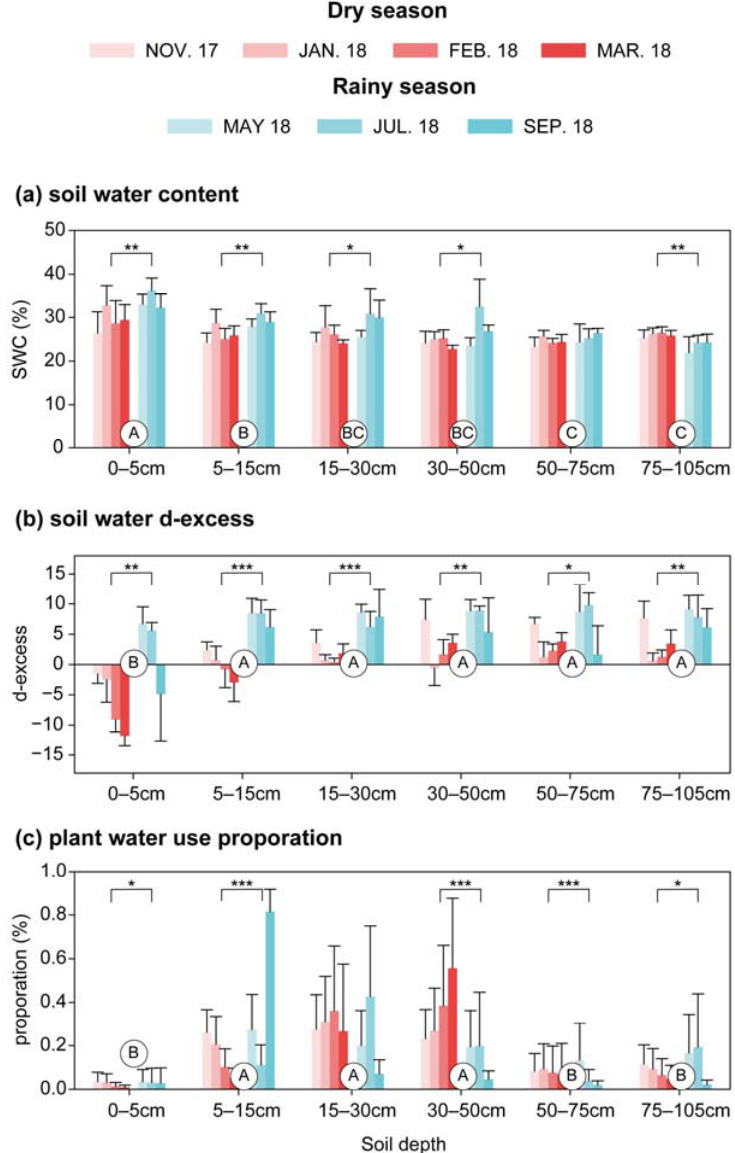
Figure 4. Differences in the ( a ) soil water content and ( b ) soil water d -excess among different soil layers and between different seasons and differences in ( c ) plant water use proportions among different soil layers. The asterisk indicates a significant difference between the dry season and rainy season (* indicates p ≤ 0.05, ** indicates p ≤ 0.01, *** indicates p ≤ 0.001).